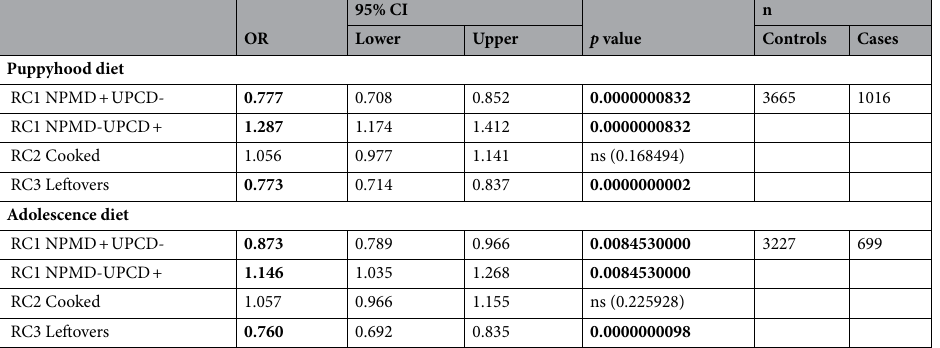
Table 3. Odds ratios (OR) of the associations between the puppyhood and adolescence diet style scores derived from principal component analysis and the incidence of chronic enteropathy (CE) in adult dogs based on multivariate logistic regression analyses (adjusted for dog gender). The inverse association of NPMD (non-processed meat-based diet) and UPCD (ultra-processed carbohydrate-based diet) in the RC1 component means that owners gave both foods in reciprocal manner so that when the amount of NPMD given for the dog was higher, the amount of UPCD given was lower and vice versa. CI = confidence interval, Cooked = Home- cooked diet, Leftovers = Human meal leftovers and table scraps, ns = not significant. Significant values are in bold.